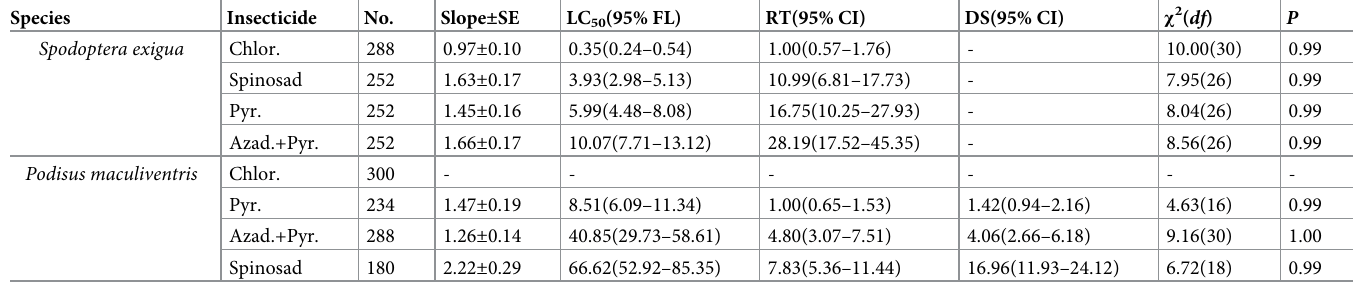
Table 2. Relative toxicity (RT) of insecticides to the 3 rd instar beet armyworm, Spodoptera exigua and RT and differential selectivity (DS) (related to the toxicity data of the beet armyworm) to the 3 rd instar spined soldier bug, Podisus maculiventris in contact toxicity on glass bioassay at 95% confidence interval.